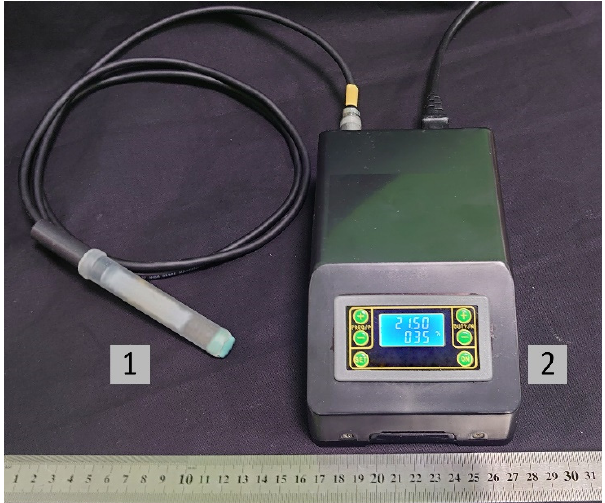
Figure 2. Photo of the “CAPKO-1” device for a CAP generation: 1—an output device with a silicone cap, on the surface of which a DBD CAP is created; 2—power supply unit and control of DBD